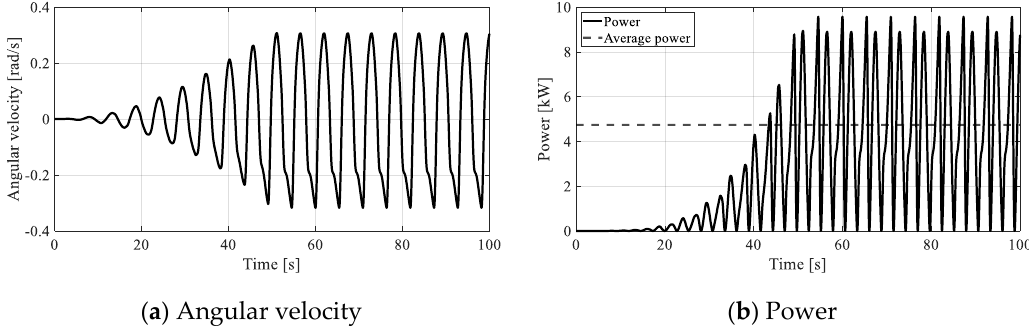
Figure 11. Time history results of the single float at Chilbaldo.